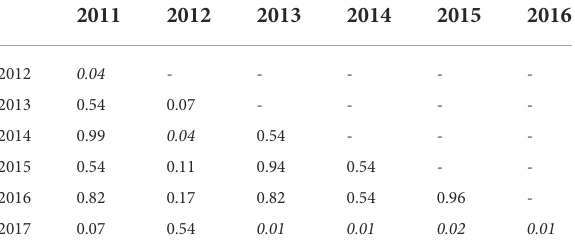
TABLE 3 Mean Shannon diversity indexes for each year were compared with a pairwise Wilcoxon rank sum test with the Benjamini – Hochberg (BH) p -value adjustment. In this table, all site types (unoiled, oiled, and reference) are pooled within the year they were collected. Signi fi cant values are in italics and indicate a statistically signi fi cant difference in the mean diversity between two years.